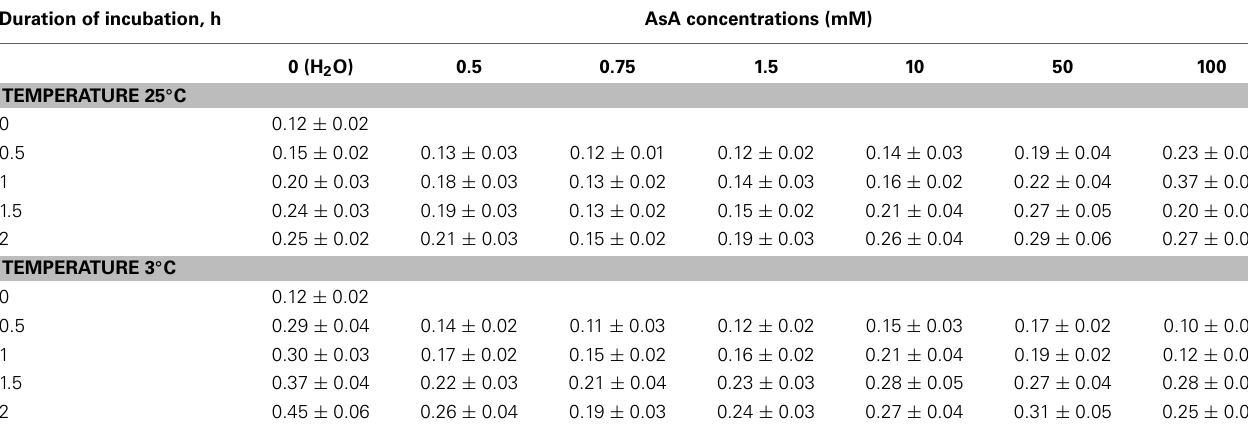
Table 1 | Effect of ascorbic acid (AsA) concentrations on O 2 • − generation ( µ M g − 1 min − 1 ) in the leaf discs of Cucumis sativus at 3 and 25 ◦ C